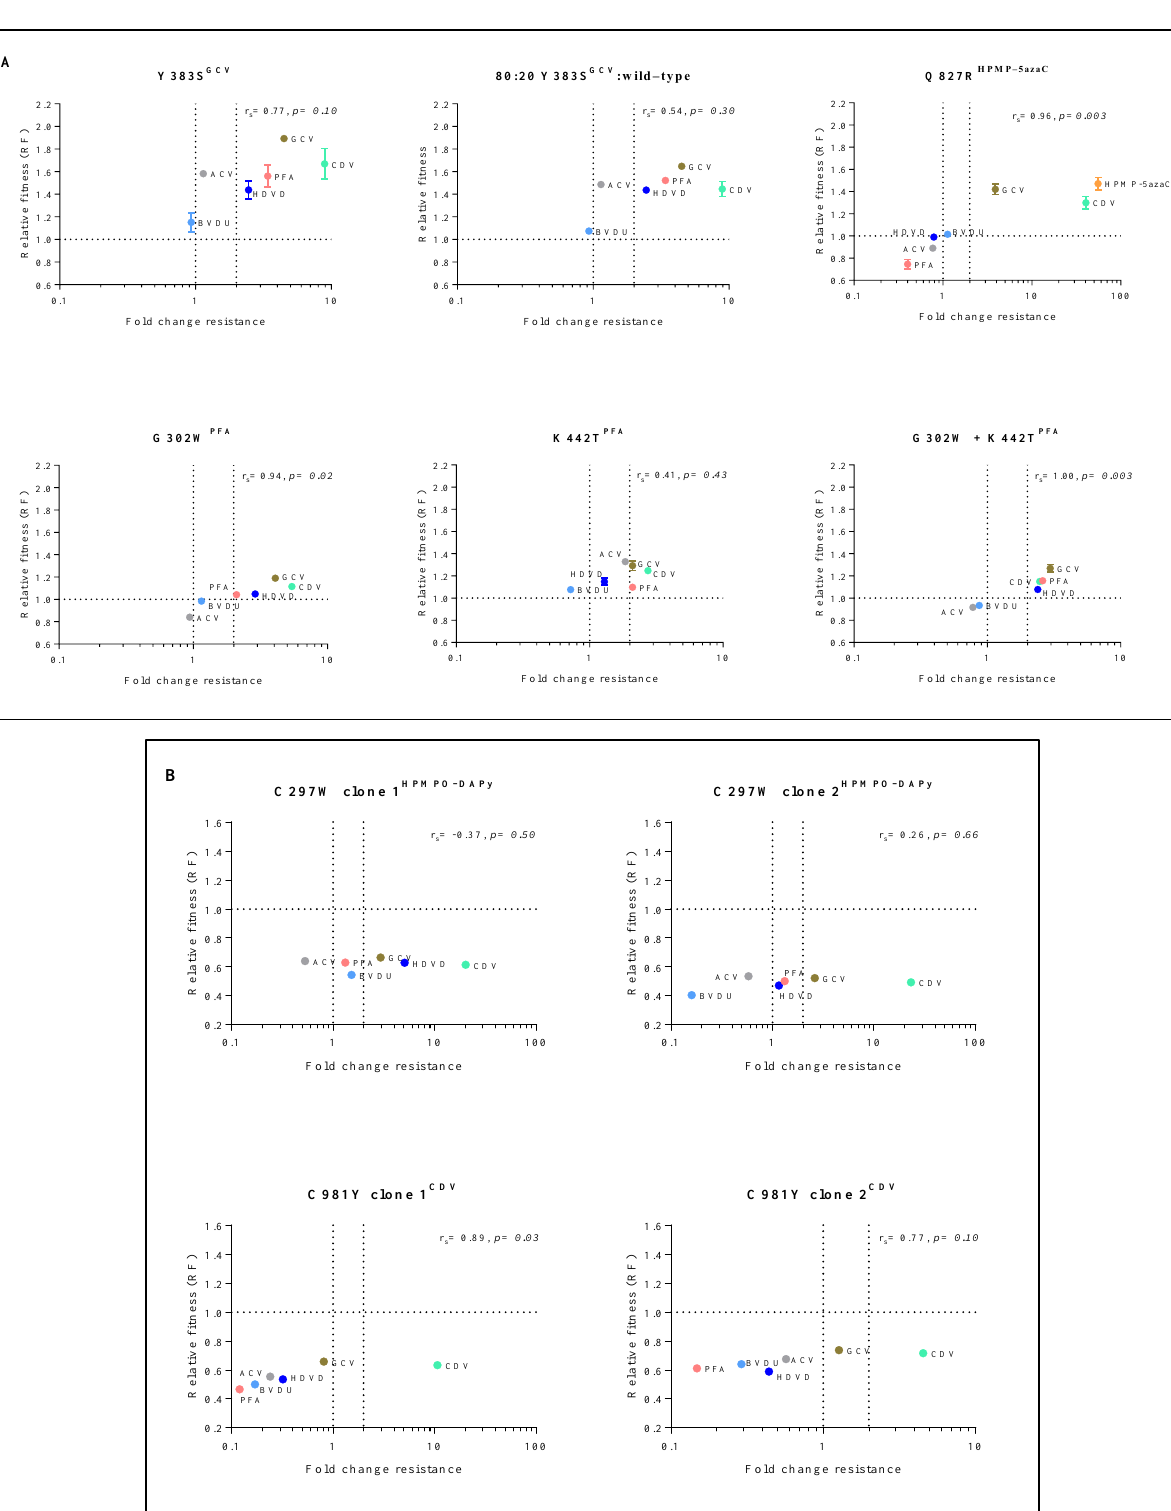
Figure 4. Correlation between relative fitness and drug resistance levels of MHV-68 viral clones bearing amino acid substitutions in the viral DP ( A ) or mutator phenotype viruses ( B ). Spearman’s rank-order correlation test was used to calculate the strength and direction of the relationship between antiviral drug resistance (fold resistance, as shown in Figure 2A,B) and relative fitness (RF, as shown in Figure 3A,B). Spearman’s correlation coefficient ( ρ , also signified by r s ) measures the strength and direction of association between two ranked variables (r s between 0.00 and 0.19 (very weak), 0.20 and 0.39 (weak), 0.40 and 0.59 (moderate), 0.60 and 0.79 (strong) and 0.80 and 1.0 (very strong)).